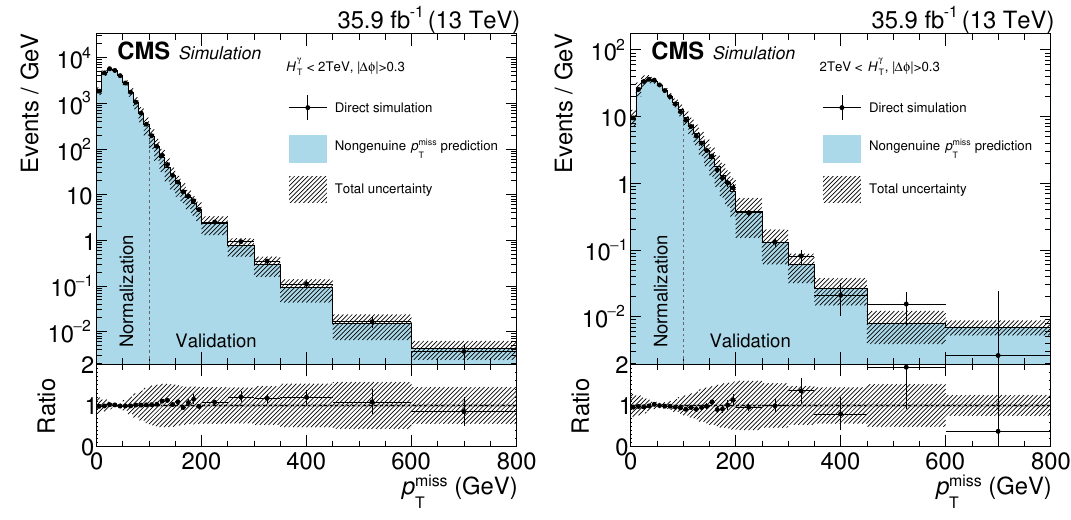
Figure 2 . Validation of the nongenuine p miss background estimation method with (cid:13) +jet and mul- T tijet simulations. The direct simulation results are shown as black dots, while the prediction using the jet CR is shown as light blue histogram. The total uncertainty of the prediction is presented as shaded area. The bottom panel shows the ratio of the direct simulation to the prediction. The low- (high-) H (cid:13) selection is shown on the left (right). The number of events corresponds to the T expectation in data for an integrated luminosity of 35.9 fb (cid:0) 1 . The rightmost bin includes all events with p miss > 600 T